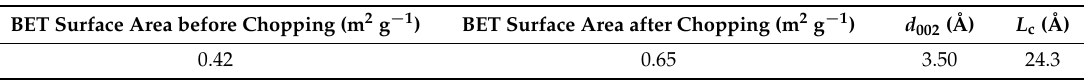
Table 1. BET surface area of IMS65 CF, as well as the XRD-derived data before and after being chopped by a Wiley mill.